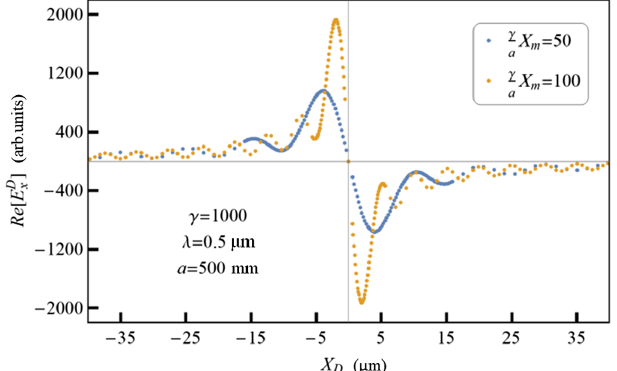
FIG. 4. Comparison of the real parts of the OTR field in the detector plane using two different lens apertures. The parameter set used for the calculation is shown in the